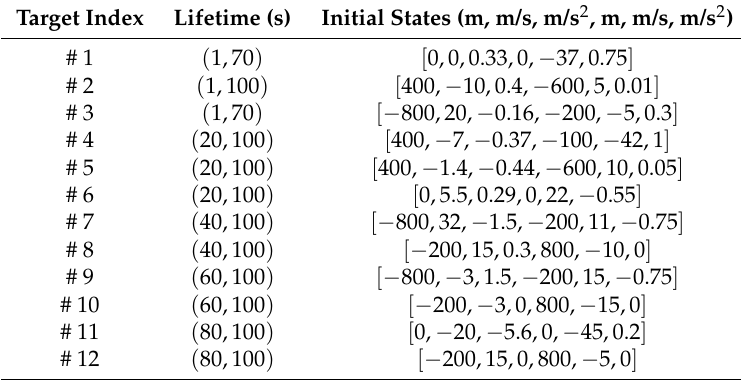
Table 2. List of initial target